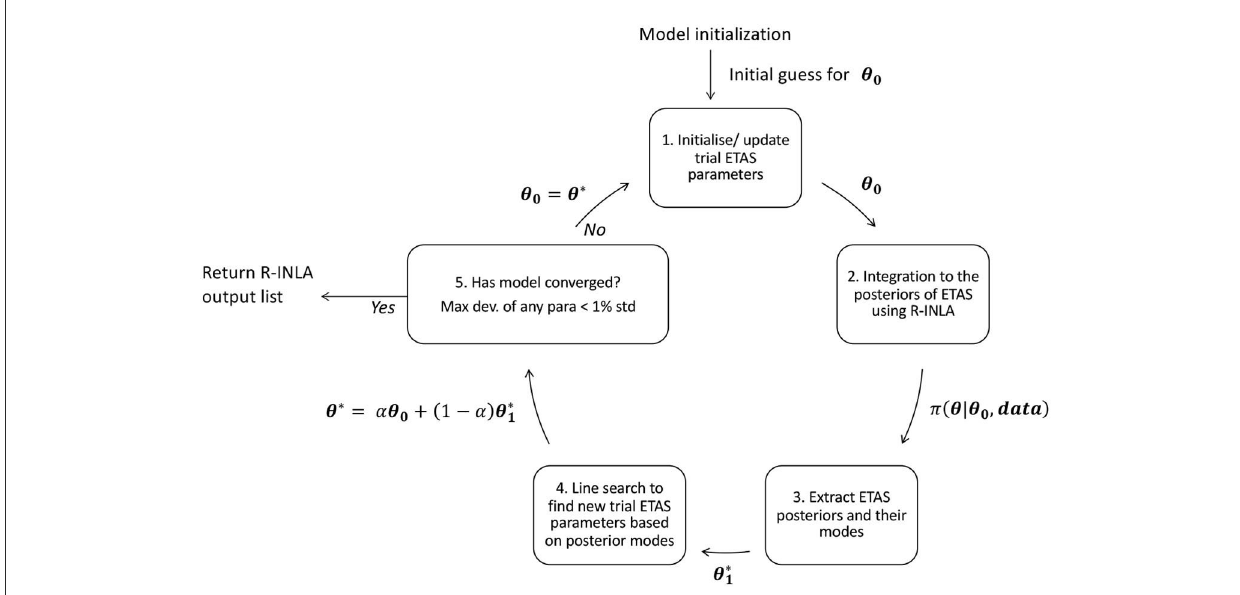
FIGURE2 Schematic diagram showing the inlabru workflow which iteratively updates a set of trial ETAS parameters.